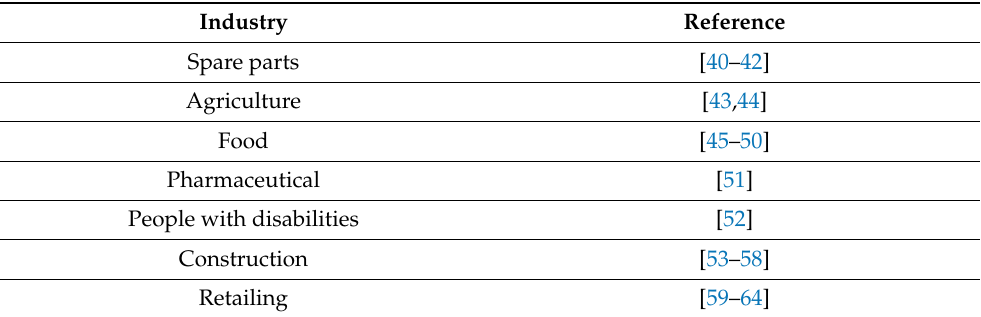
Table 3. Application of IoT in inventory management in different